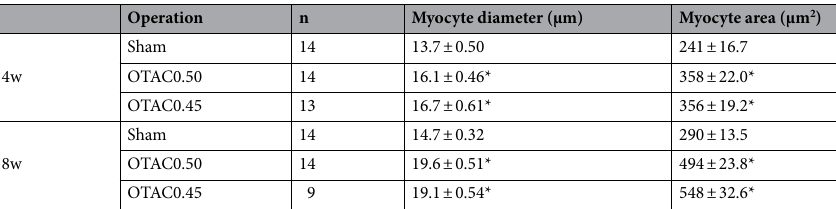
Table 4. Average measurements of myocardial tissue structure for each group in mice. Data are expressed as the mean ± standard error of the mean. Myocyte cross-sectional area and diameter of short axis were measured in sham mice or O-ring induced transverse aortic constriction (OTAC) mice at terminal sacrifice. Terminal sacrifice was performed in 4 weeks and 8 weeks after procedures. O-rings had inner diameters of 0.50 mm (OTAC0.50) and 0.45 mm (OTAC0.45). n = 14 in the Sham group; n = 14 in O-TAC0.50 group; n = 9–13 in O-TAC0.45 group. Comparison among groups were performed by one-way analysis of variance (ANOVA) with Tukey’s post hoc tests (* P < 0.05 vs.